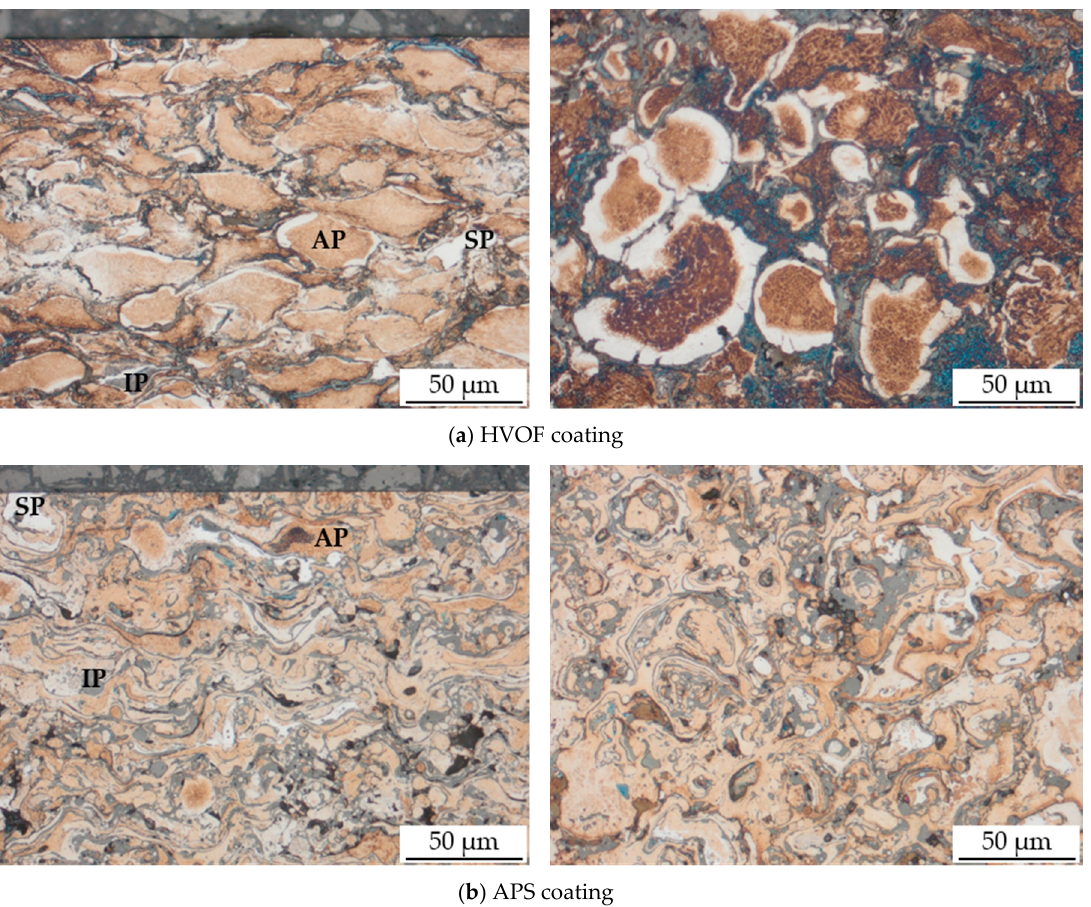
Figure 4. Optical-microscopic images of a Beraha-II etched AISI 316L thermal spray coatings in cross-section ( left ) and top-view ( right ) with phase declaration ( a : high velocity oxy-fuel (HVOF) coating; b : atmospheric plasma spraying (APS) coating; SP—S-phase; AP—austenitic phase; IP—impurity).